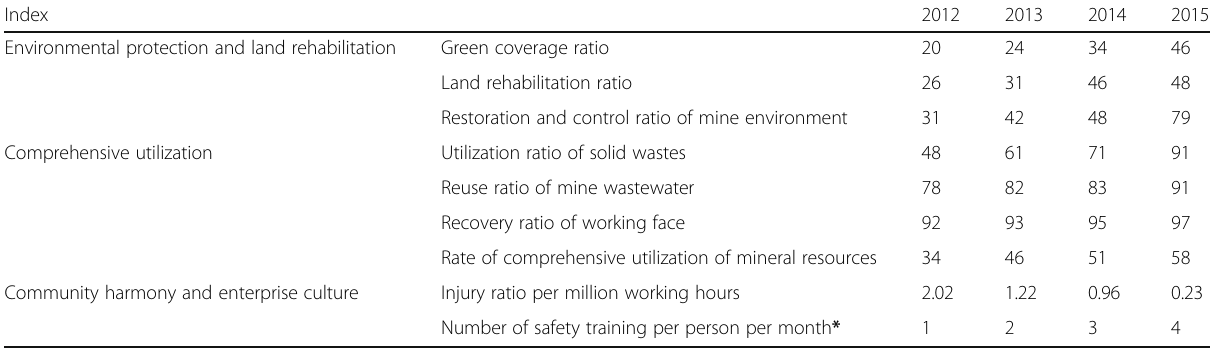
Table 2 Percentage (%) of green mining